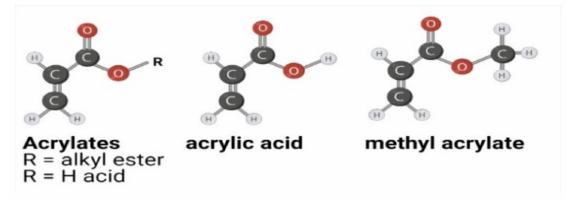
Figure 1. Structure for